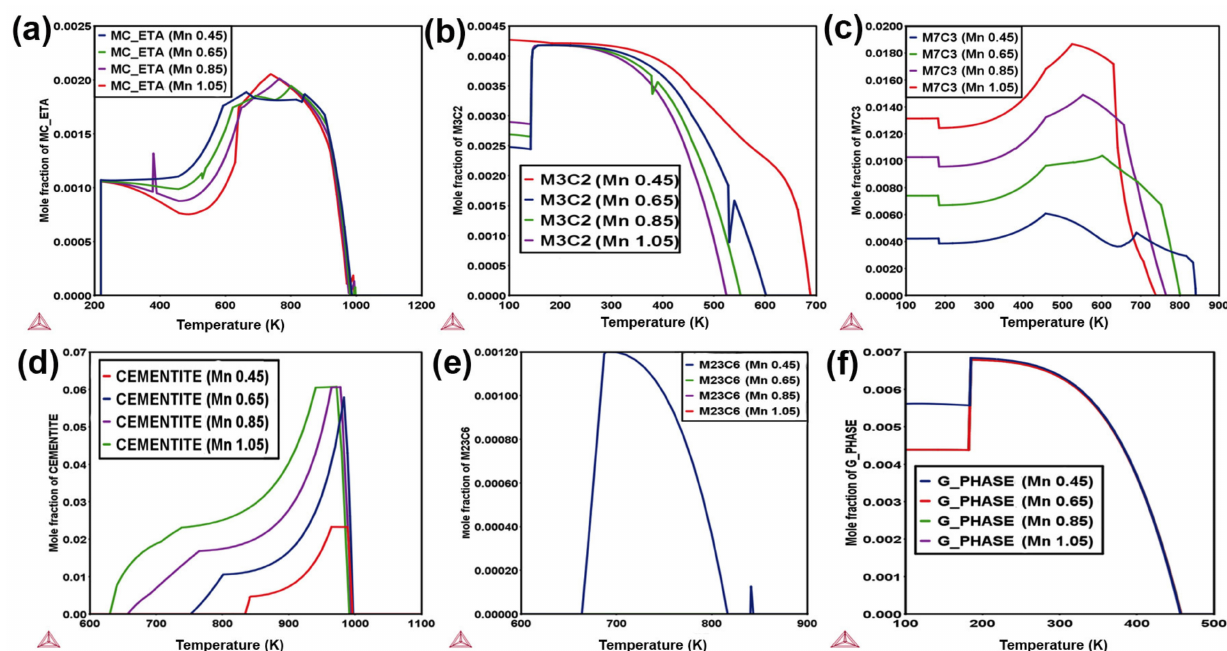
Figure 3. Effect of Mn concentration to MS2 alloys for, ( a ) MC_ETA; ( b ) M 3 C 2 ; ( c ) M 7 C 3; ( d ) cementite; ( e ) M 23 C 6 ; ( f )